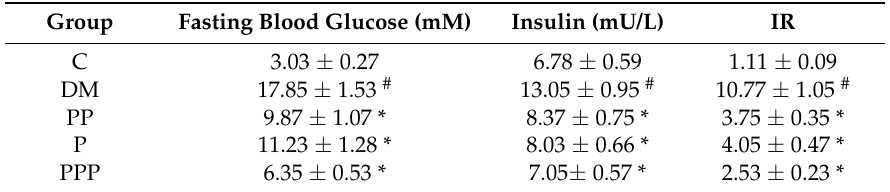
Table 1. The effect on the serum glucose and insulin level.